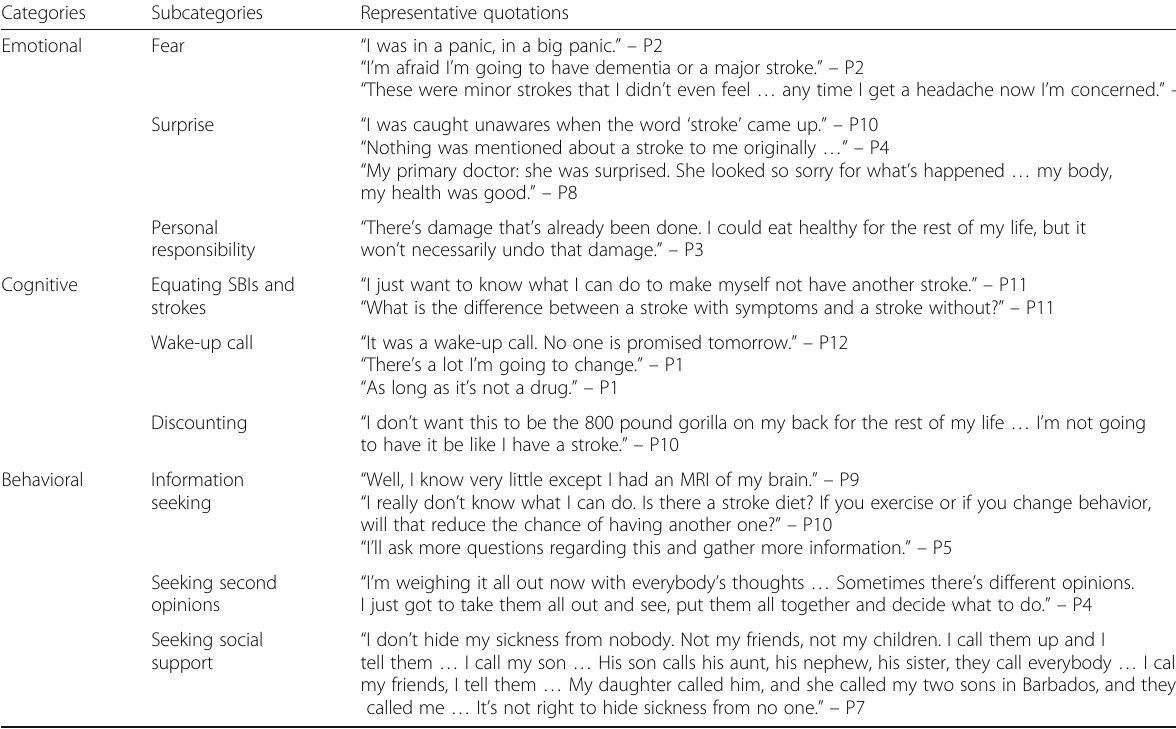
Table 2 Participants ’ responses to the incidental discovery of SBIs